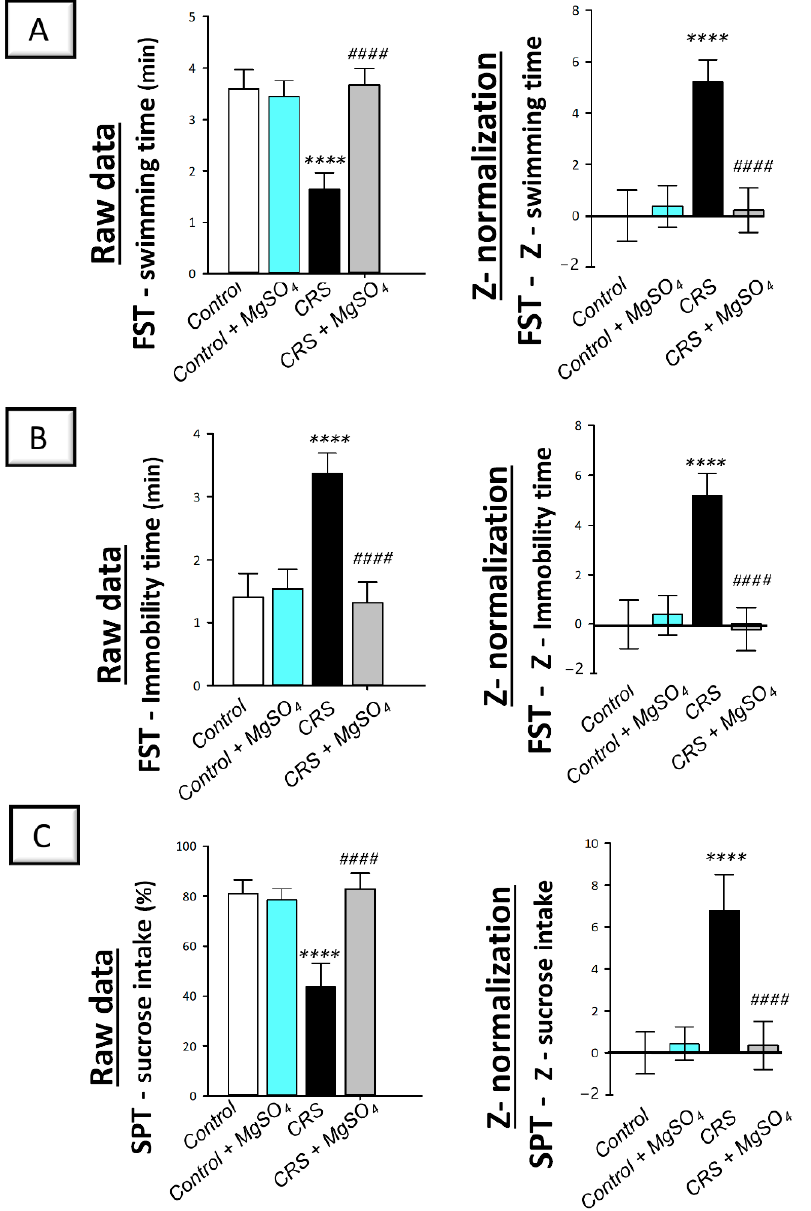
Figure 2. Effect of magnesium sulfate on the depression-like behavioral deficits triggered by chronic restraint stress (CRS) in the forced swimming test (FST) and sucrose preference test (SPT) in rats. Administration of magnesium sulfate attenuated the depression-like behavioral deficits that were invoked by CRS. The beneficial effects of magnesium sulfate were demonstrated by the increased swimming time [F (3, 20) = 50.79, p < 0.0001] ( A ) and lowered immobility time [F (3, 20) = 50.80, p < 0.0001] ( B ) in the FST alongside the increased sucrose intake percentage [F (3, 20) = 46.77, p < 0.0001] in the SPT ( C ). Calculation of Z-values was described in the material and methods Section 4.5.4. using the control group as the baseline. Z-values are expressed as the mean of 6 Z-scores ± standard deviation (S.D.). Statistical analysis was applied using one-way ANOVA followed by Tukey’s post-hoc test. Significant differences versus control animals are denoted by **** p < 0.001. Significant differences versus CRS group are denoted by # ### p < 0.001. CRS, chronic restraint stress; MgSO 4 , magnesium sulfate.